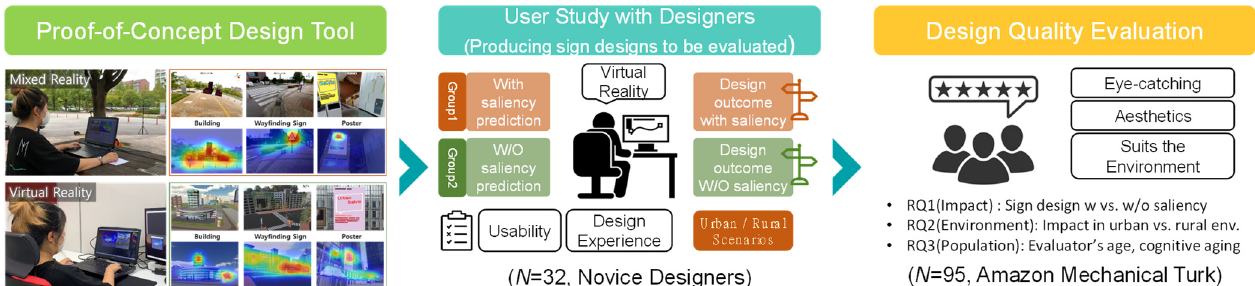
Figure 2. Overview of the study design. We built a proof-of-concept urban design tool to assess the effect of providing saliency feedback during the urban design process. For a sanity check, we recruited 32 designers who used the tool for design to test its usability and design experience both with and without saliency prediction. The produced design outcomes were evaluated by 95 participants to assess the impact of saliency prediction on the design quality (RQ1) according to the environment (RQ2) and the evaluator’s age (RQ3).